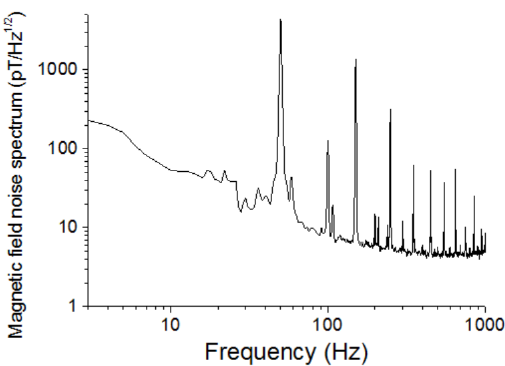
Figure 15. Magnetic field noise spectrum measured by the FeCoSiB amorphous wire magnetic sensor in the laboratory without shielding.